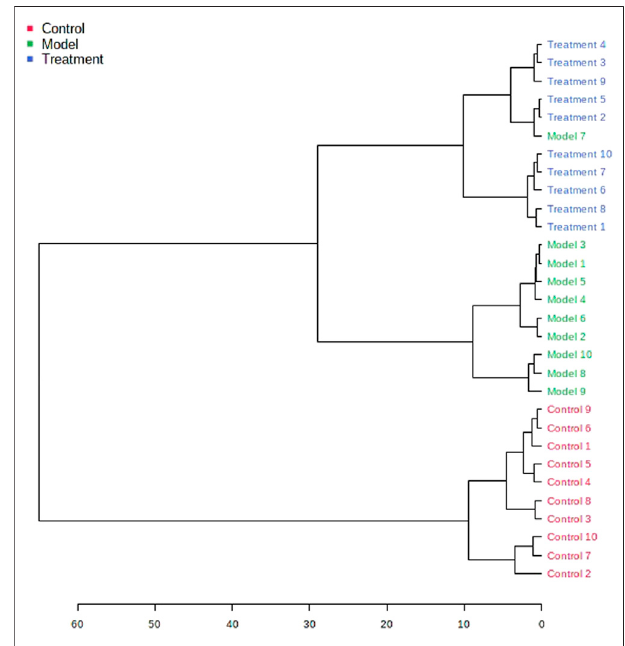
FIGURE 7 | Hierarchical clustering dendrogram for the control, model, and treatment